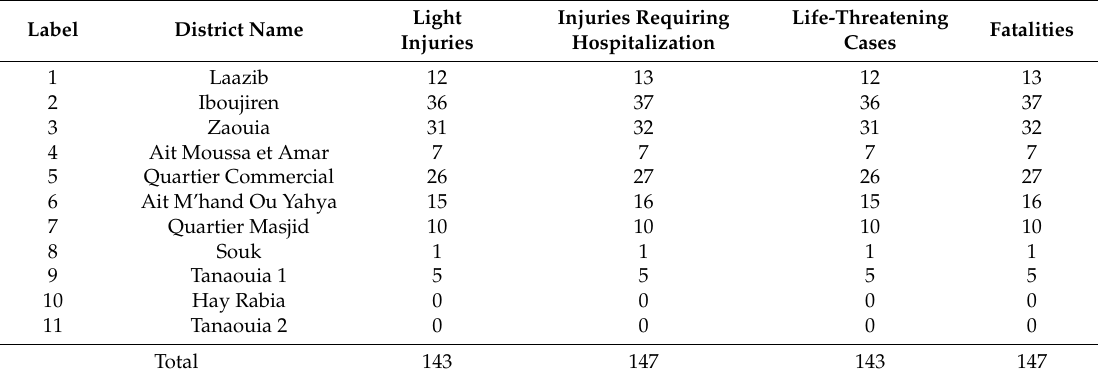
Table 6. Number of casualties for the deterministic scenario for each district in